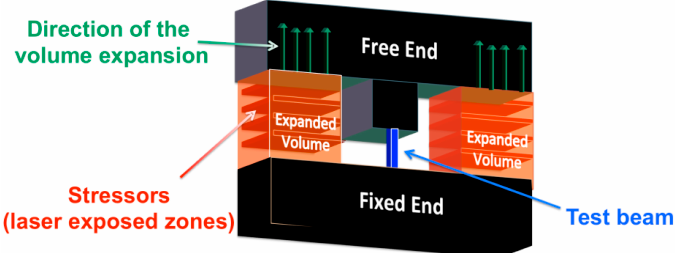
Figure 2. Illustration of the loading cell’s working principle. The two loading bars (red areas) expand during femtosecond laser exposure resulting in the loading of the middle (blue) test beam.